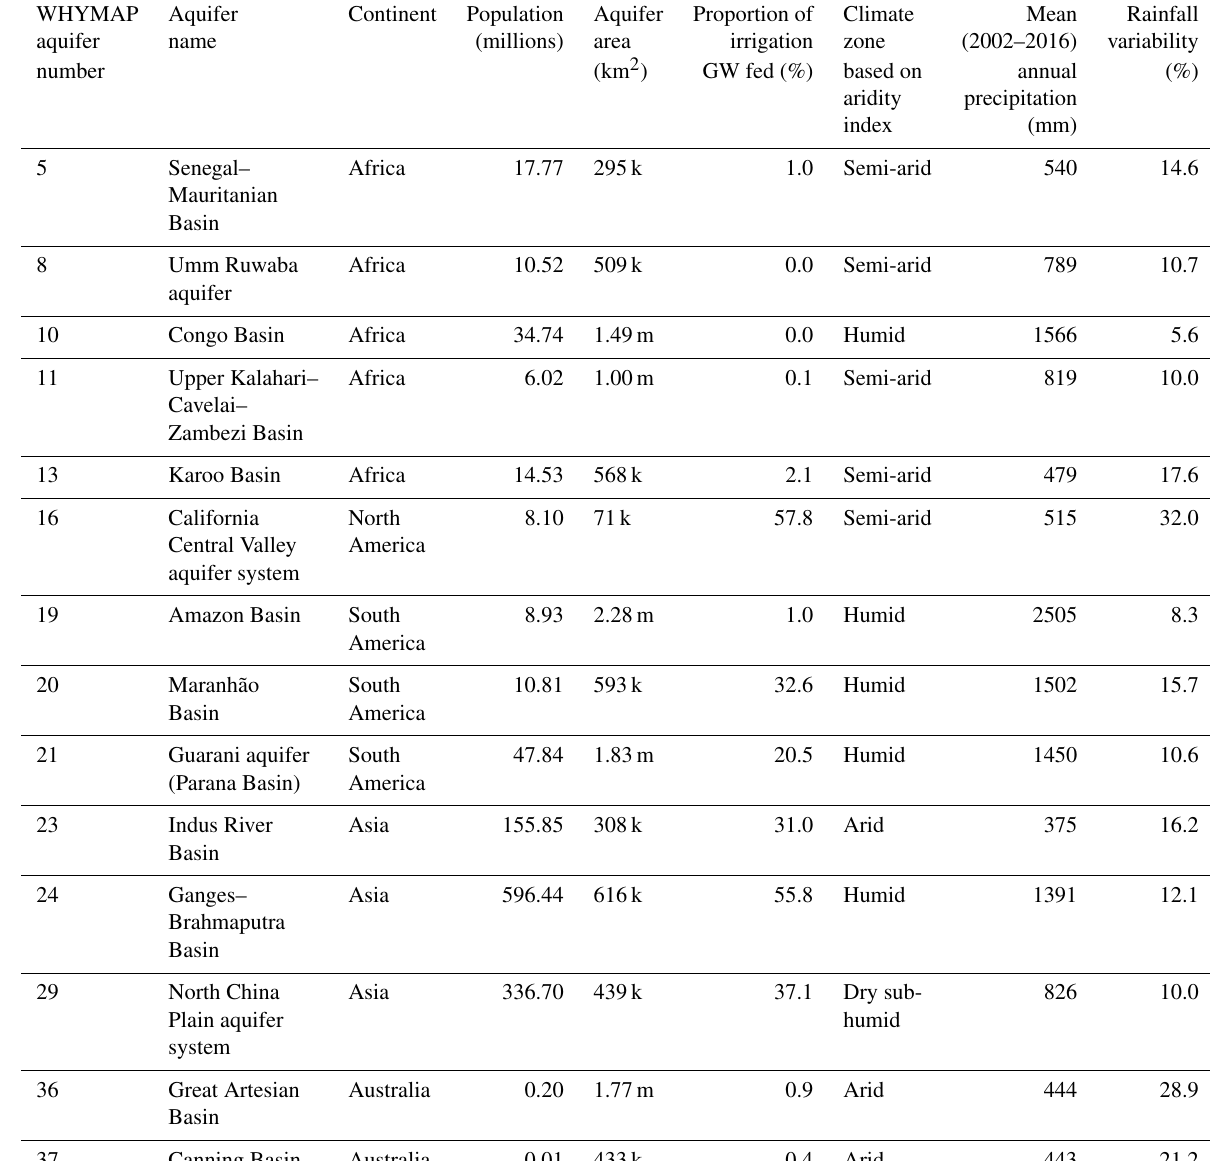
Table 1. Characteristics of the 14 aquifer systems selected for the study according to the WHYMAP and CGIAR-CSI databases with statistics giving (L to R): total number of resident population, aquifer area, proportion of groundwater-fed irrigation, mean aridity index classification (Trabucco and Zomer, 2019), mean annual rainfall and mean variability in annual